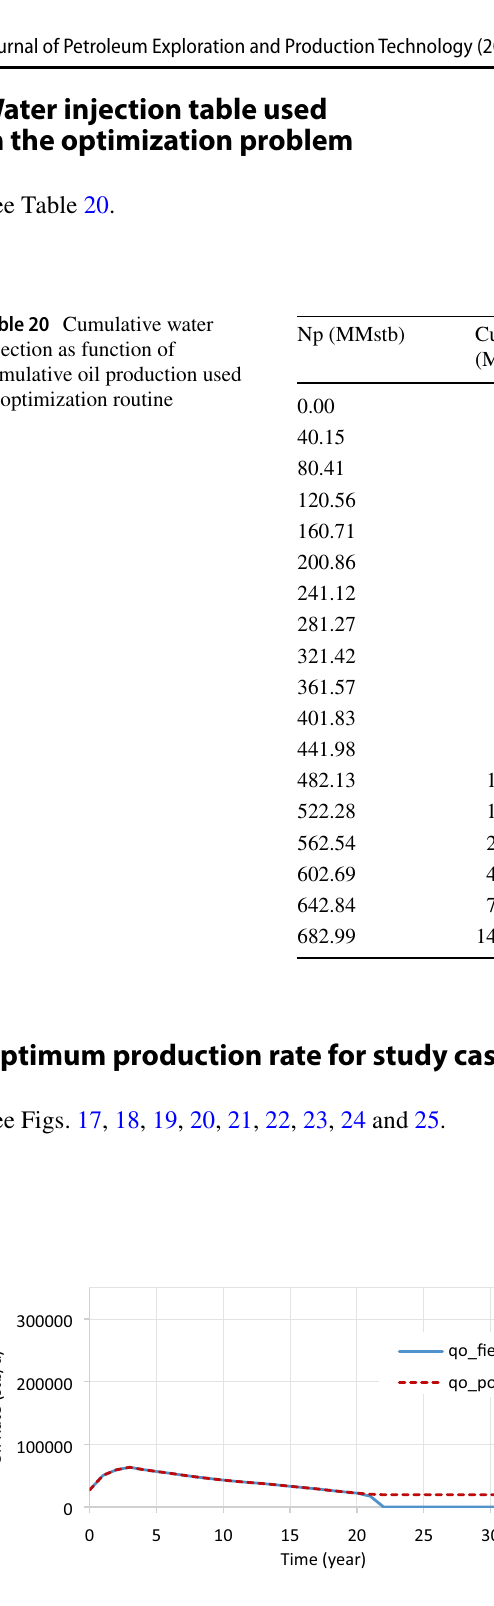
Fig. 17 Optimum oil production profile and oil production potential for strategy TLP with GL